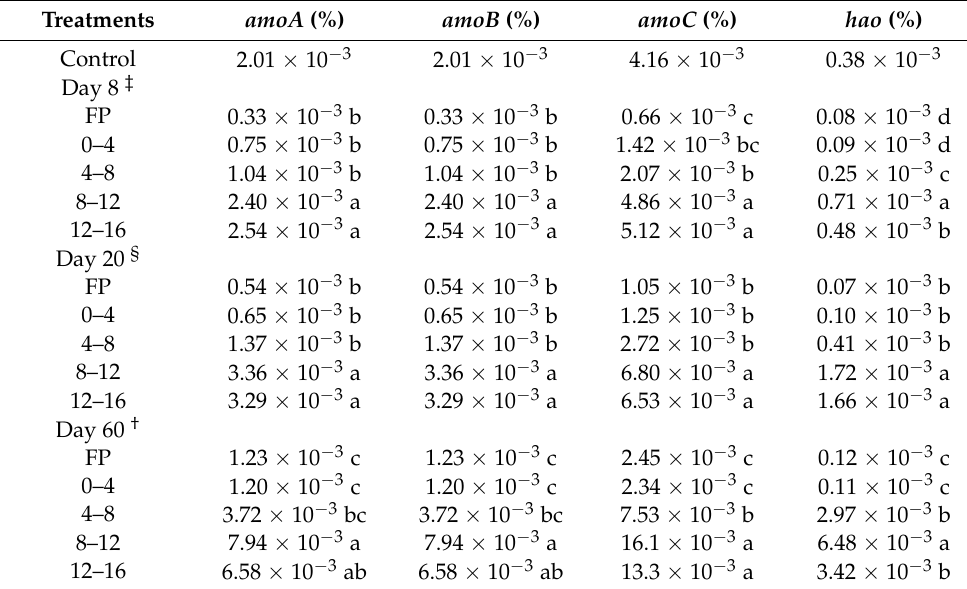
Table 3. The putative abundance of nitrification genes under different treatments and incubation times for Qidong (QD)